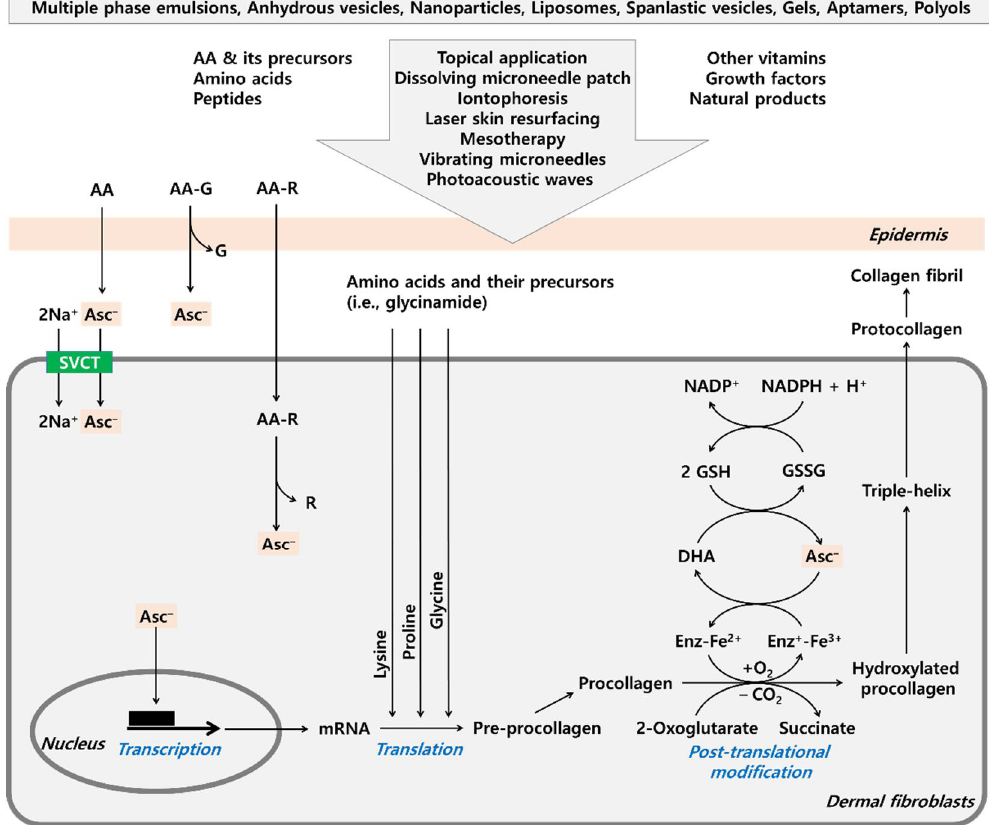
Figure 1. Various strategies to enhance the efficacy of ascorbic acid (AA) increasing dermal collagen. AA is present as ascorbate mono-anion (Asc − ) at neutral pH. The efficacy of AA may be synergis- tically enhanced by combined formulation with other active ingredients, such as other vitamins, amino acids, peptides, growth factors, and natural products. The incorporation of AA into multiple phase emulsions, anhydrous vesicles, nanoparticles, liposomes, spanlastic vesicles, gels enhances the stability and skin permeation of AA. Aptamers and polyols help stabilize AA. To enhance skin permeation of AA, its topical application can be combined with other procedures, such as iontophore- sis, laser skin resurfacing, mesotherapy, and the use of vibrating microneedles and photoacoustic waves. AA-loaded dissolving microneedle patches are also useful for this purpose. AA glycosides and hydrophobic AA precursors can be used instead of AA for higher stability in cosmetic products and a more effective supply of AA to skin cells. AA glycosides (AA-G) are enzymatically hydrolyzed to release AA as they pass through the skin. While AA enters cells through the SVCT family, hy- drophobic AA precursors (AA-R) can enter cells through simple diffusion and be converted to AA by intracellular enzymes. In the process of collagen production, AA stimulates the mRNA expression of procollagen genes at the transcription stage. AA also enhances the hydroxylation of procollagen at the post-translational modification stage, by acting as a cofactor of 2-oxoglutarate-dependent dioxygenase (Enz). AA reduces the iron ions at the active sites of the enzyme while it is oxidized to dehydroascorbate (DHA). DHA is enzymatically reduced to AA in a reaction coupled with the oxidation of glutathione (GSH) to glutathione disulfide (GSSG). GSSG is reduced to GSH in a reaction coupled with the oxidation of nicotinamide adenine dinucleotide phosphate hydrogen (NADPH) to nicotinamide adenine dinucleotide phosphate (NADP + ). Amino acids can serve as the building blocks of proteins needed at the translation stage. In particular, glycine, proline, and lysine, or their precursors, can help facilitate collagen